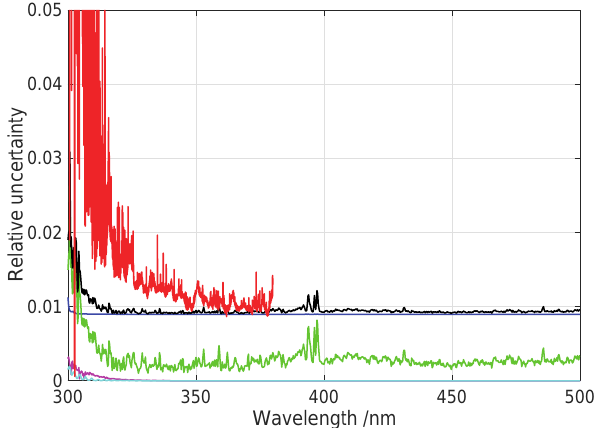
Figure 5. Relative uncertainty of the solar extraterrestrial spectra derived from the direct solar irradiance measurements using the Langley-plot method. The red and black curves represent the total relative uncertainties of the FTS and QASUME respectively. The remaining curves represent the uncertainty contributions calculated for QASUME for the direct solar irradiance measurements (blue), the Langley-plot variability (green), the effective ozone height (ma- genta) and the bandwidth correction